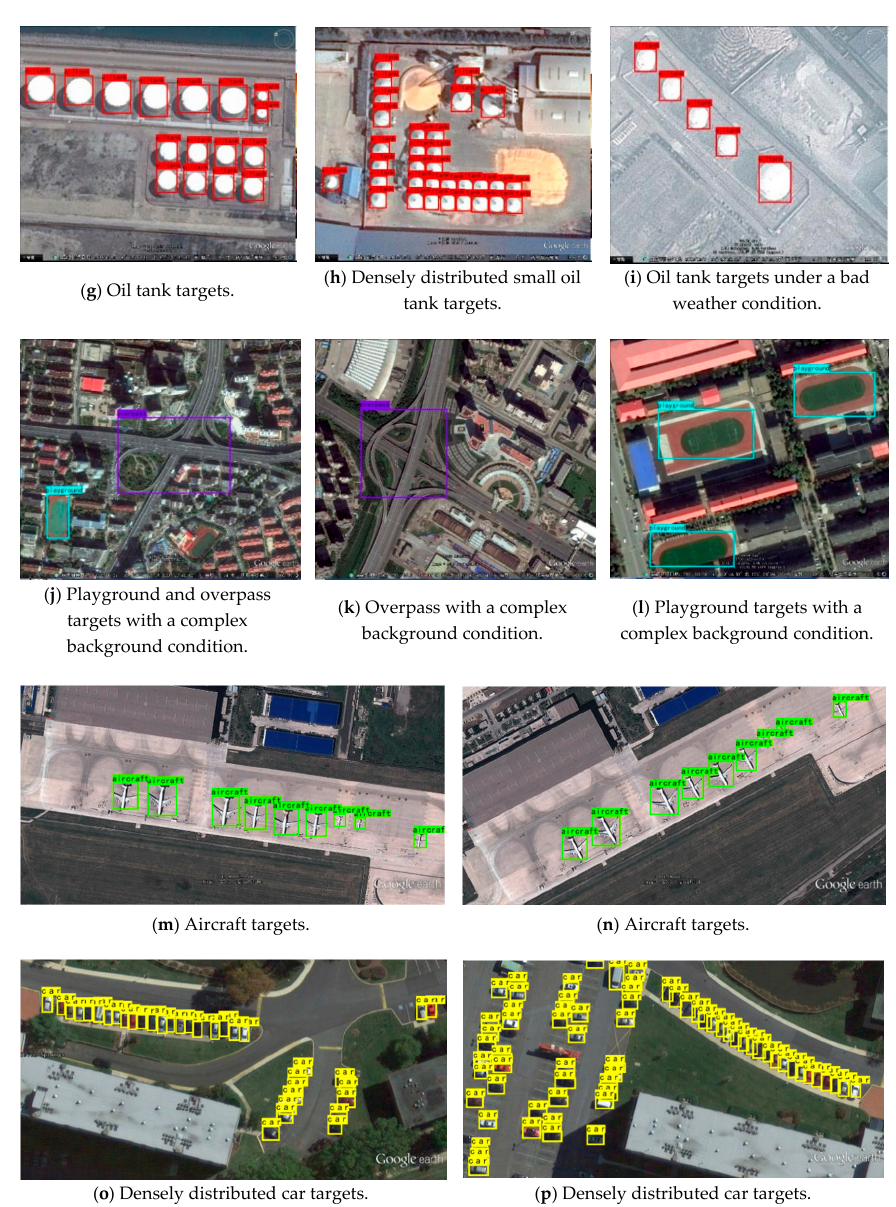
Figure 8. The detection results of the improved You Only Look Once (YOLO)-V3.